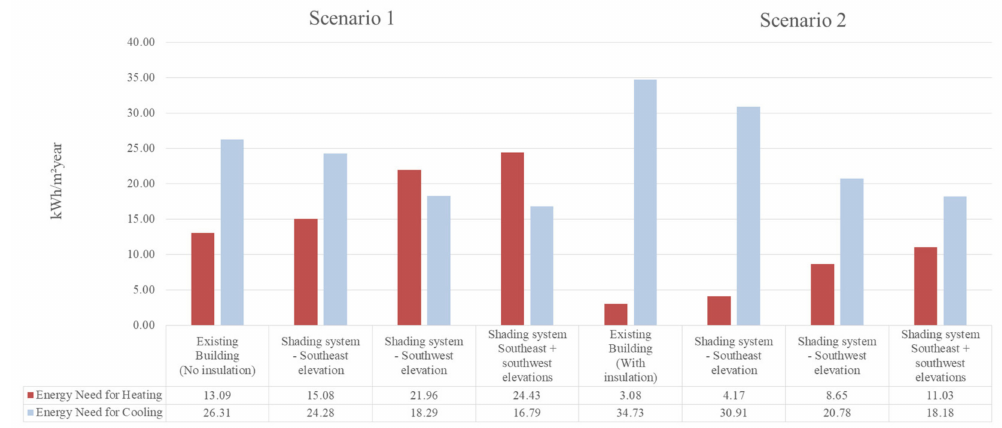
Figure 11. Calculation of the energy need (kWh/m 2 year) with CYPETHERM HE Pus—scenarios 1 and 2.